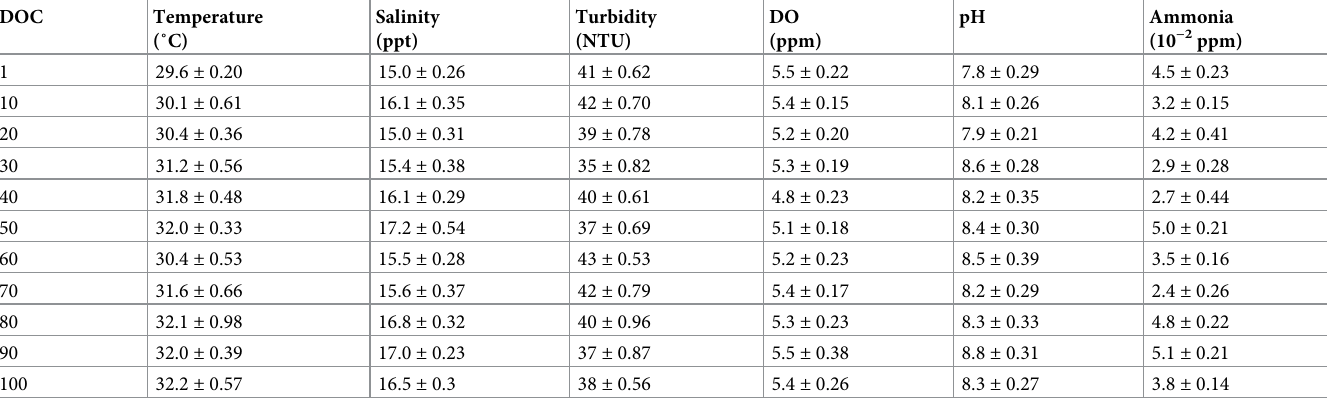
Table 3. Key water quality parameters recorded during the culture